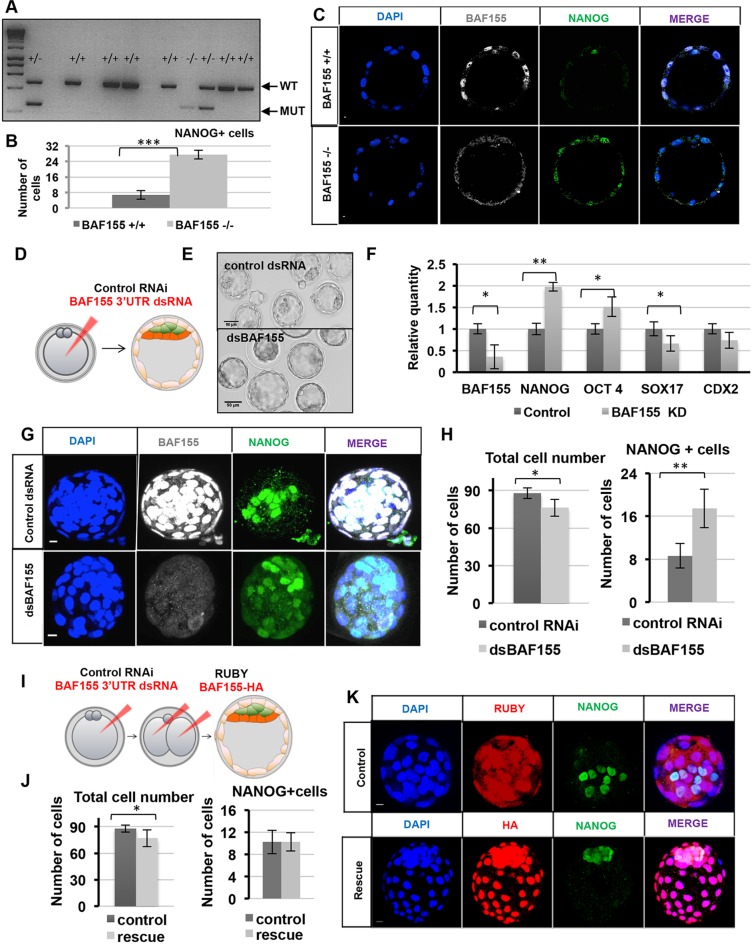
BAF155 is required for Nanog downregulation during lineage specification at the blastocyst stage. (A) Three-primer single-embryo PCR analysis from Baf155 heterozygous intercrosses showing wild-type (450 bp) and mutated (250 bp) alleles. The first lane contains a size marker (1 kb HyperLadder). (B) Baf155−/− embryos have a significantly increased number of NANOG+ cells compared with control littermate embryos (***P<0.01, Student's t-test). (C) Baf155−/− embryos exhibit ectopic nuclear expression of NANOG in TE (determined morphologically), unlike Baf155+/+ littermates that only have nuclear NANOG expression in the EPI cells. (D) Downregulation of BAF155 at the zygote stage was performed using dsRNA against the 3′UTR (dsBAF155), or control dsRNA. (E) DIC images of embryos injected with control dsRNA or dsBAF155. (F) qRT-PCR of whole embryos, comparing lineage marker transcripts of control and dsBAF155 blastocysts. (G) z-projections of immunofluorescent images of control and dsBAF155 E4.5 blastocysts. (H) The total number of cells in control E4.5 blastocysts (88±4) was slightly reduced compared with dsBAF155 blastocysts (76±7). The number of NANOG+ cells in dsBAF155 blastocysts was increased (17±4) compared with the control (9±3). (I) Rescue experiment of BAF155-depleted embryos. (J) Rescue blastocysts had fewer cells (77±9) than control blastocysts (87±5), but the same number of NANOG+ cells. (K) No ectopic expression of NANOG in TE was detected in the majority of rescued blastocysts. Error bars represent s.d. *P<0.05, **P<0.01, ***P<0.001, Student's t-test. Scale bars: 10 µm.